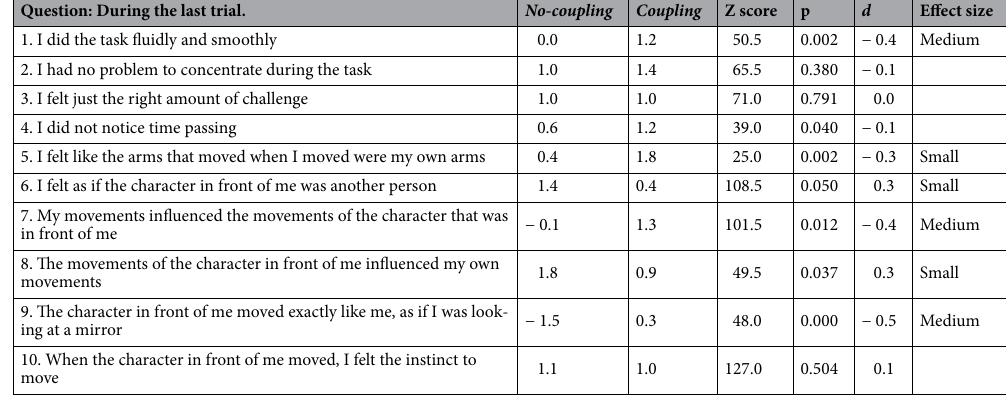
Table 1. Questionnaire responses. Wilcoxon tests comparing the graded responses to the coupling condition with the graded responses to the no coupling condition. The values reported are the median values for each condition, the Z score, the p value and Cliff’s delta. The effect size is estimated from this last